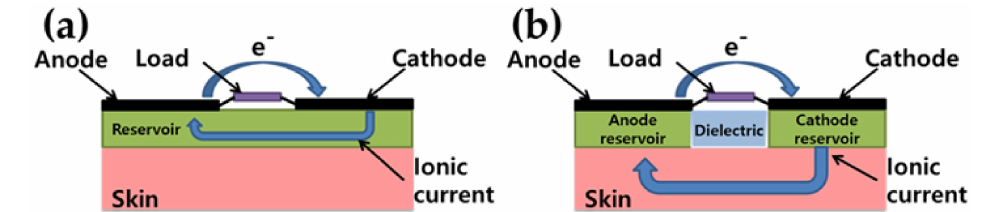
Figure 8. Possible architectures for skin EFCs with reservoir: ( a ) one reservoir, conductive; ( b ) two separated reservoirs with dielectric separation for the ionic current through the skin—a porous transpirant microlayer at skin / reservoir interphase may be